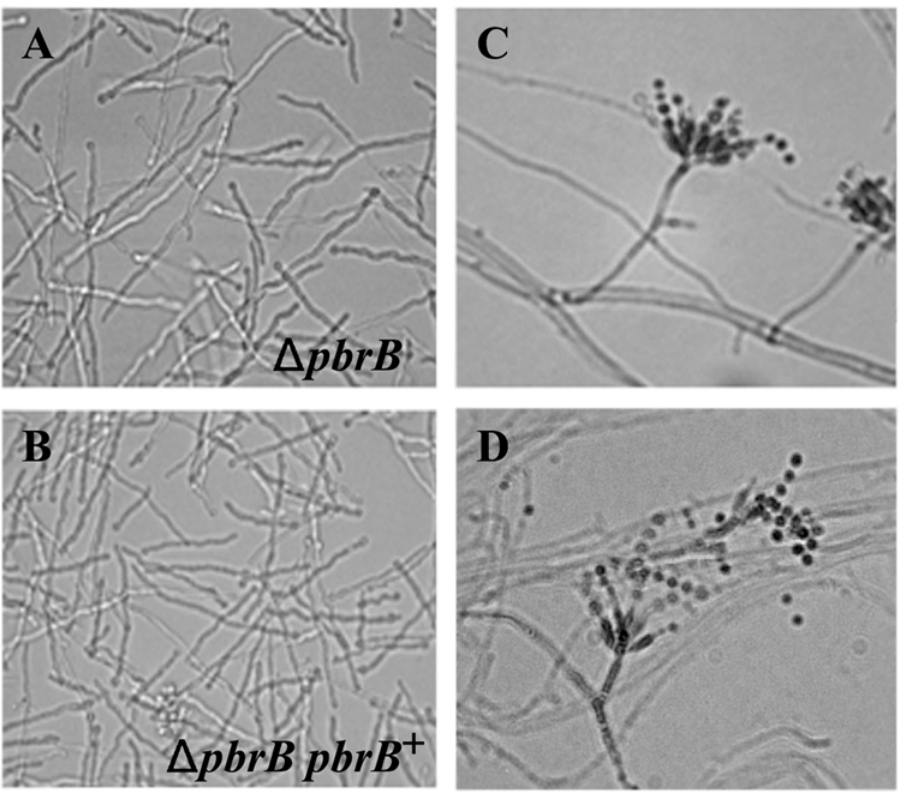
Fig 6. Germination and growth of the Δ pbrB strain. Microscopic imaging of the T . marneffei Δ pbrB and Δ pbrB pbrB + strains grown at 28°C for 24 h to assess germination (A, B) and 7 days to observe conidiophores (C, D). Microscopic images were captured at 200X (A, B) and 400X (C, D) magnification.